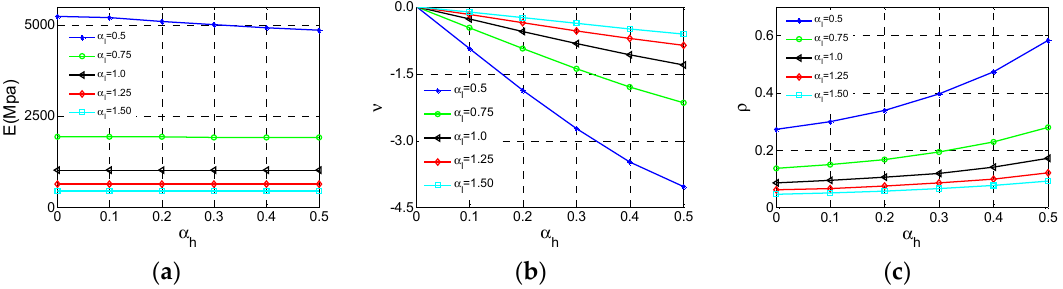
Figure 12. The changes of the effective properties with respect to the height ratio α h and the length ratio α l for Type C cell: ( a ) effective Young’s modulus E ; ( b ) effective Poisson ratio v ; ( c ) relative density ρ .